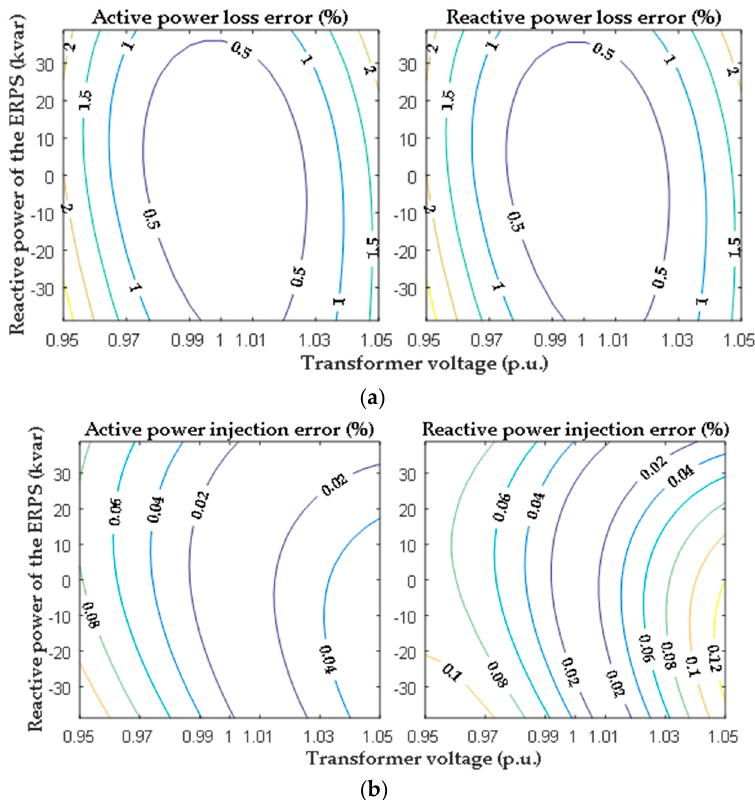
Figure A1. Error in the network power loss and residual power injection for low-voltage system 2. ( a ) Network power loss; and ( b ) residual power injection.